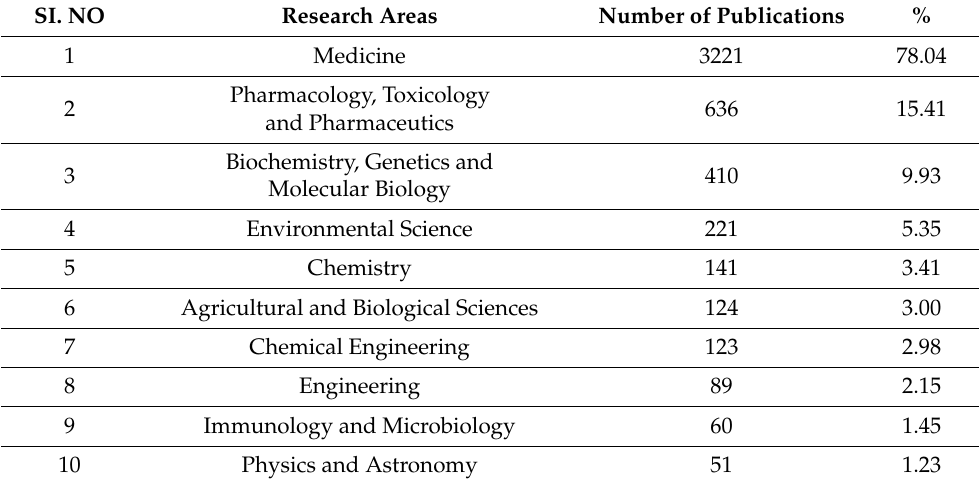
Table 2. The first ten research areas of the publications related to cosmetic adverse effects literature. SI. NO